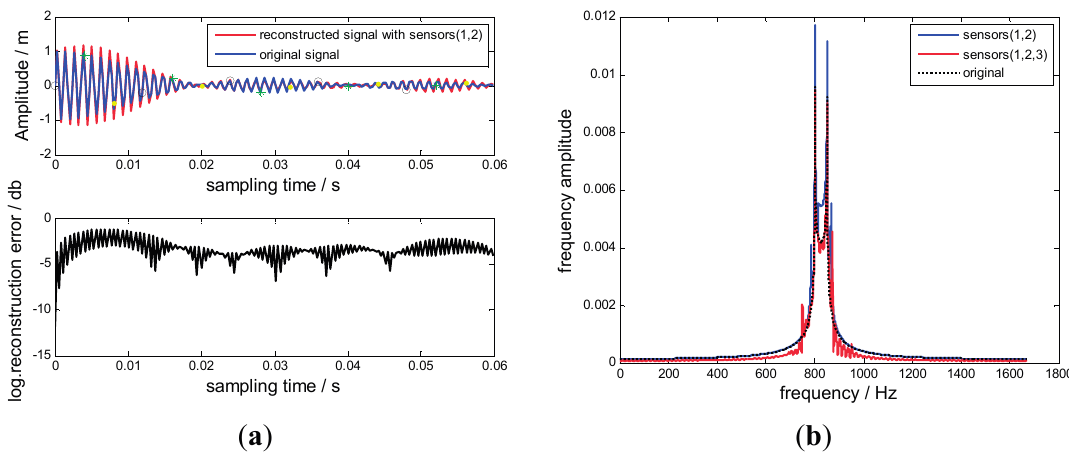
Figure 14. Reconstructed signals with the probes offset in ( a ) time-domain and ( b )